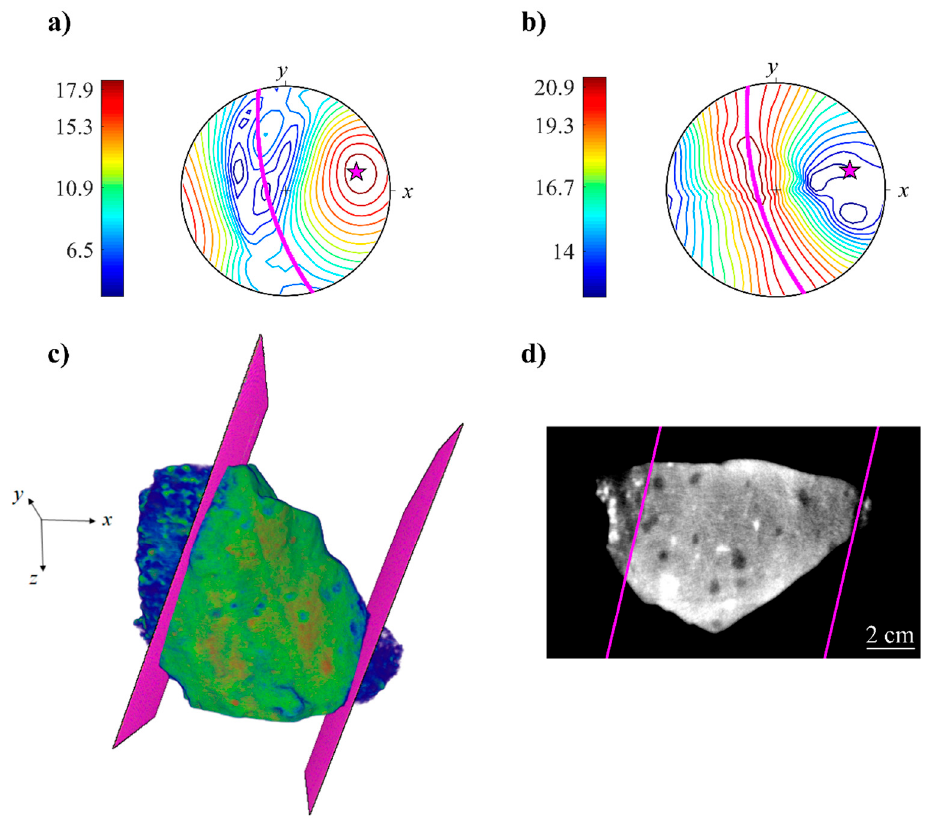
Figure 4. The calculated stereoplots of in-plane σ P ( a ) and in-line σ L ( b ) spatial variations of neutron attenuation coefficient for Sample_1. The scale bar in the diagram is shown in a.u. Magenta stars and lines denote the direction of maximum σ P and the corresponding plane normal to this direction. The obtained virtual models of plane-parallel dike walls are shown by magenta color in 3D model ( c ) and selected 2D slice ( d ).